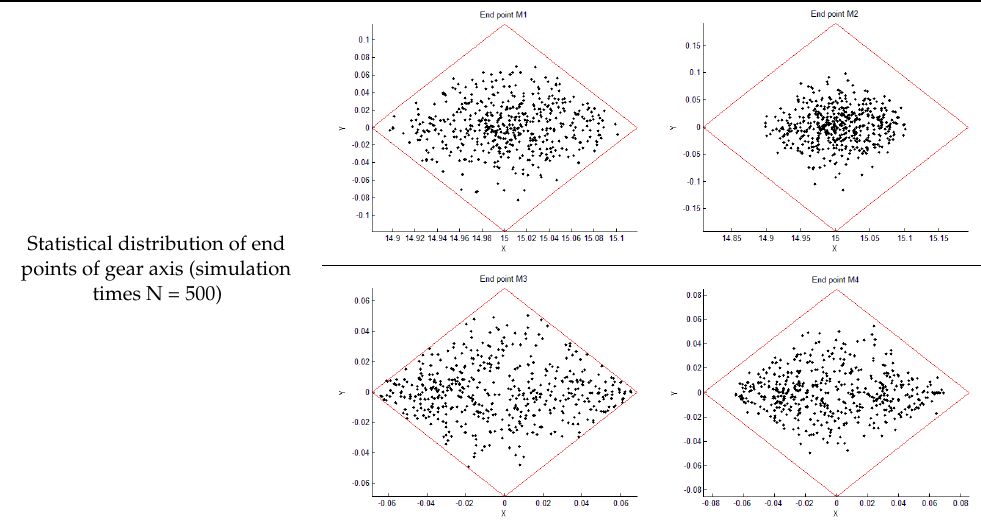
Table 5. Statistical distribution of end points of the gear axis.